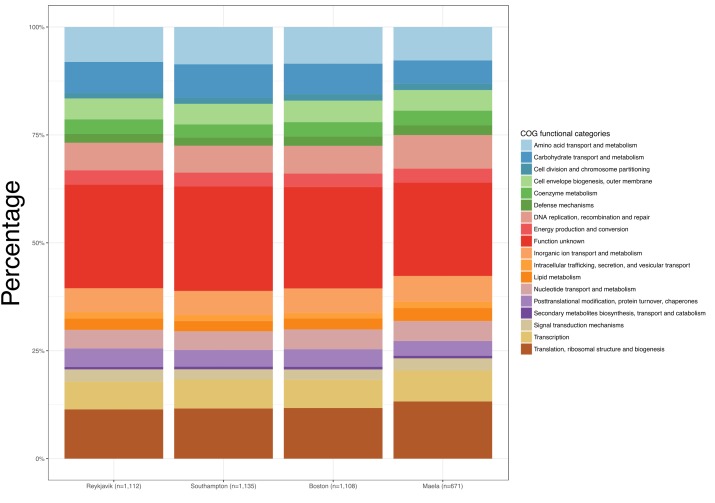
Bar graphs depicting the Clusters of Orthologous Groups (COGs) functional categories for each set of estimated core genes.